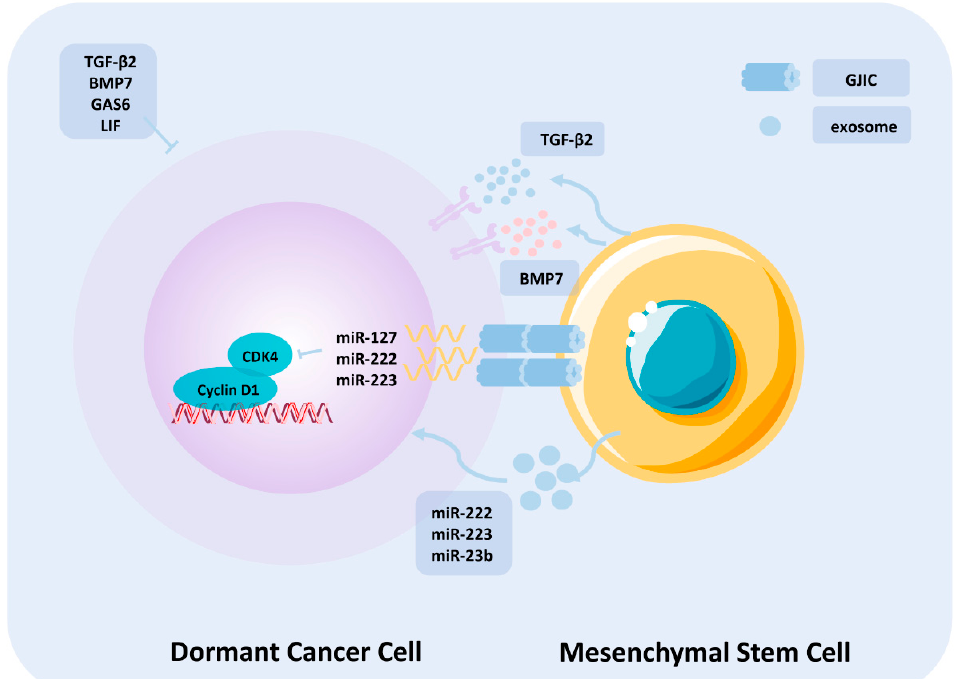
Figure 1. Mechanism of mesenchymal stem cells maintaining cancer cells’ dormancy. Apart from the cytokines present in the tumor microenvironment responsible for the maintenance of cancer-cell dormancy, MSCs also exert pivotal functions in arresting cell-cycle progression, mainly through three mechanisms: (1) intercellular communication of miRNA directly through gap-junction intercellular communication (GJIC) to reduce transcription of cell-cycle components, thus blocking the G0/G1 transition; (2) transportation of miRNA-containing exosomes to exert the same effect as direct communication; and (3) secretion of TGF- β 2 and BMP7 from NG+/Nestin+ mesenchymal stem cells to activate p27 and p38 to induce dormancy. Abbreviations: BMP7, bone morphogenetic protein 7; GAS6, growth arrest specific 6; LIF, leukemia inhibitory factor; GJIC, gap-junction intercellular communication.